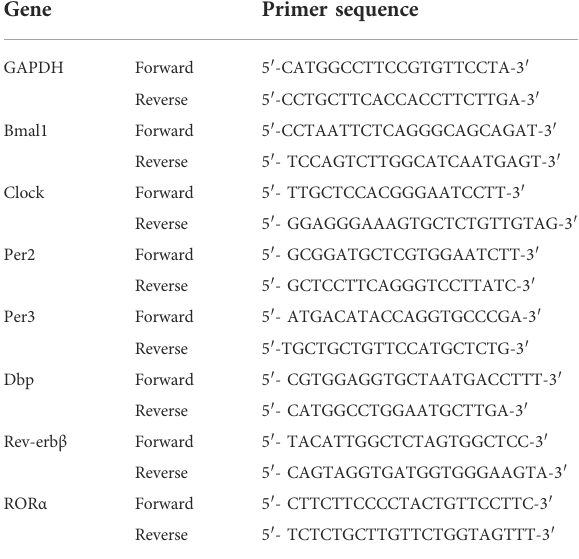
TABLE 1 Primer sequences used for quantitative RT-PCR analysis. Gene Primer sequence